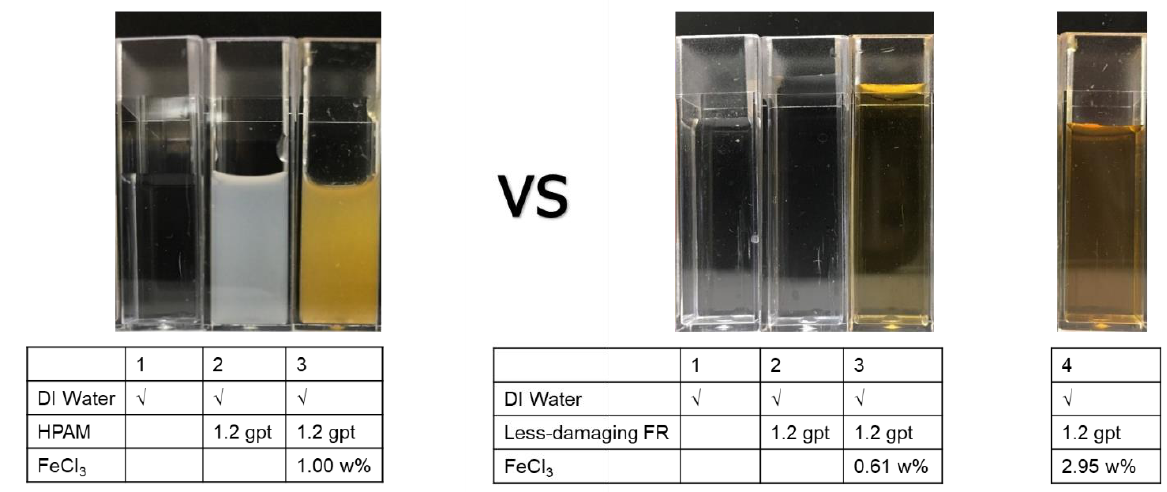
Figure 15—HPAM vs. a less-damaging FR in FeCl flocculated; Less-damaging FR: no